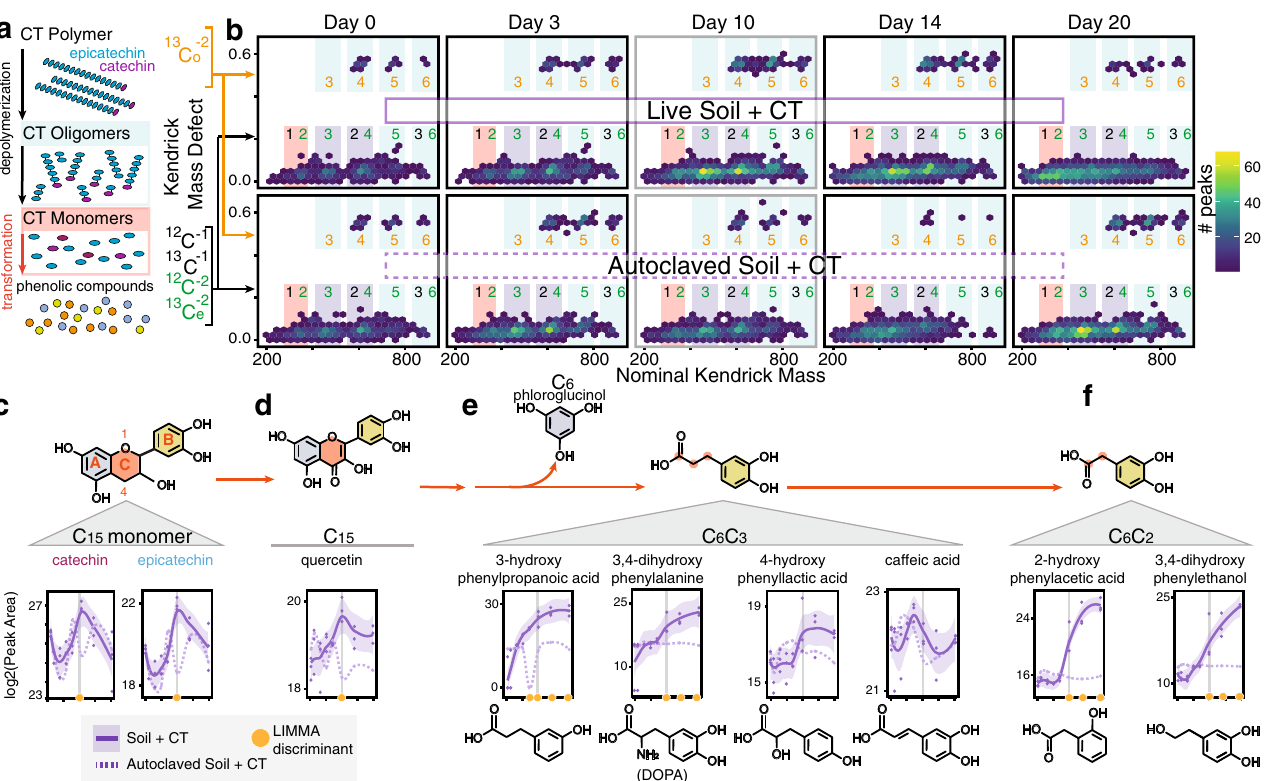
Fig. 2 Metabolomic evidence for anoxic degradation of a model polyphenol in soil. a Model CT polymers have an average degree of polymerization of 16, with repeating epicatechin (blue) units capped with a terminal catechin (magenta). Depolymerization breaks the inter fl avan bonds of the polymer backbone, generating smaller sized oligomers and monomers. These can be further transformed, by biotic or abiotic processes, to lower molecular weight phenolic compounds. b Kendrick mass defect (KMD) hex plots for the peaks detected in replicate C of biologically-active (top) and autoclaved (bottom) CT-amended microcosms. KMD is given relative to (epi)catechin. Hex plots divide plot area into equal size hexagons, and hexagons are colored according to the number of data points that fall in that area. At left, peak information that enabled oligomer assignments is shown by colors where 13 C o (orange) and 13 C 13 C, respectively (see Supplementary Fig. 4 for detailed examples). e (green) denote doubly-charged compounds containing odd and even numbers of Colored rectangles are shown around regions where CT oligomers (blue) and monomers/dimers (pink) and their derived compounds are expected to occur, with key regions highlighted in purple. Corresponding colored numbers indicate oligomer sizes: monomer (1), dimer (2), trimer (3), tetramer (4), pentamer (5), and hexamer (6) peaks. Kendrick plots for all replicates at all timepoints are found in Supplementary Fig. 6A – C. c – f Metabolites detected via LC – MS can be organized into c CT C 15 monomers (epicatechin, catechin), d other C 15 fl avonoids (quercetin), e C 6 -C 3 phenolic compounds, and f C 6 -C 2 phenolic compounds. Metabolite dynamics are shown with lines indicating average peak area ( n = 3 individual biological replicates) for CT (purple) microcosms, and shaded areas the 95% con fi dence interval with individual data points plotted. Dotted lines show signal from autoclaved CT-amended soil control. Orange circles indicate timepoints at which active soil signal signi fi cantly differed from autoclaved soil signals (LIMMA, p < 0.05, log2FC> 1.5, see Supplementary Data 1 for exact p-values). Vertical gray lines mark day 10. In the illustration of the monomer structure in ( c ), red letters label fl avonoid rings, and red numbers correspond to C-ring